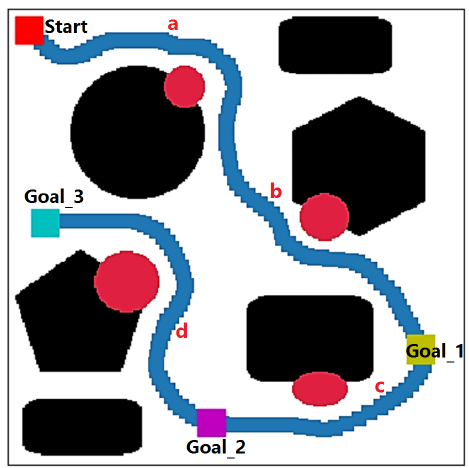
Figure 16. Multi-goal path planning in a dynamic